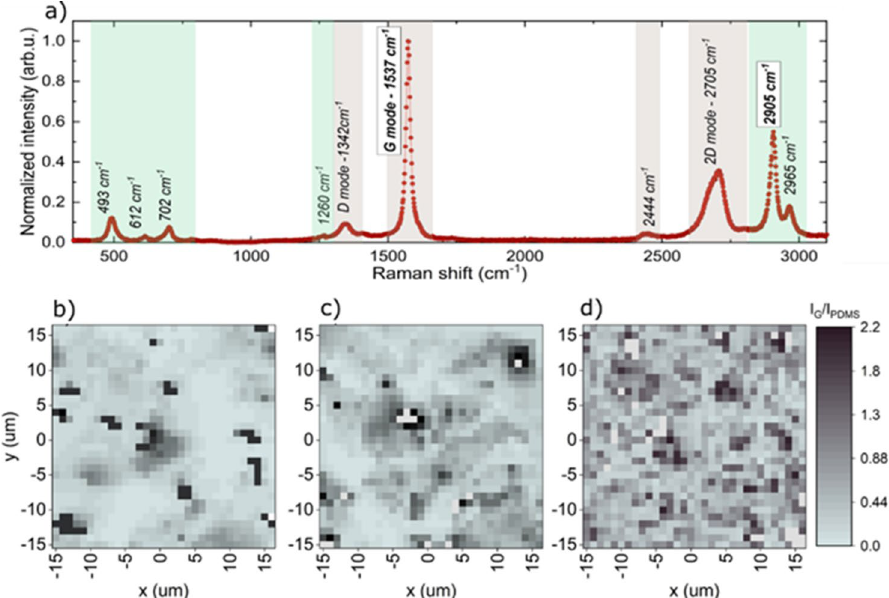
Figure 3. ( a ) A typical Raman spectrum of graphene/PDMS nanocomposite induced by laser wavelength λ = 532 nm at room temperature. Light green areas indicate the most prominent PDMS-based Raman modes, light grey areas indicate graphene-based Raman modes, ( b ) Raman maps of normalized intensity ratio of graphene G-band (1573 cm −1 ) to the polymer PDMS band (2905 cm −1 ) of sample PDMS M, ( c ) sample PDMS K, ( d ) sample PDMS HPH.